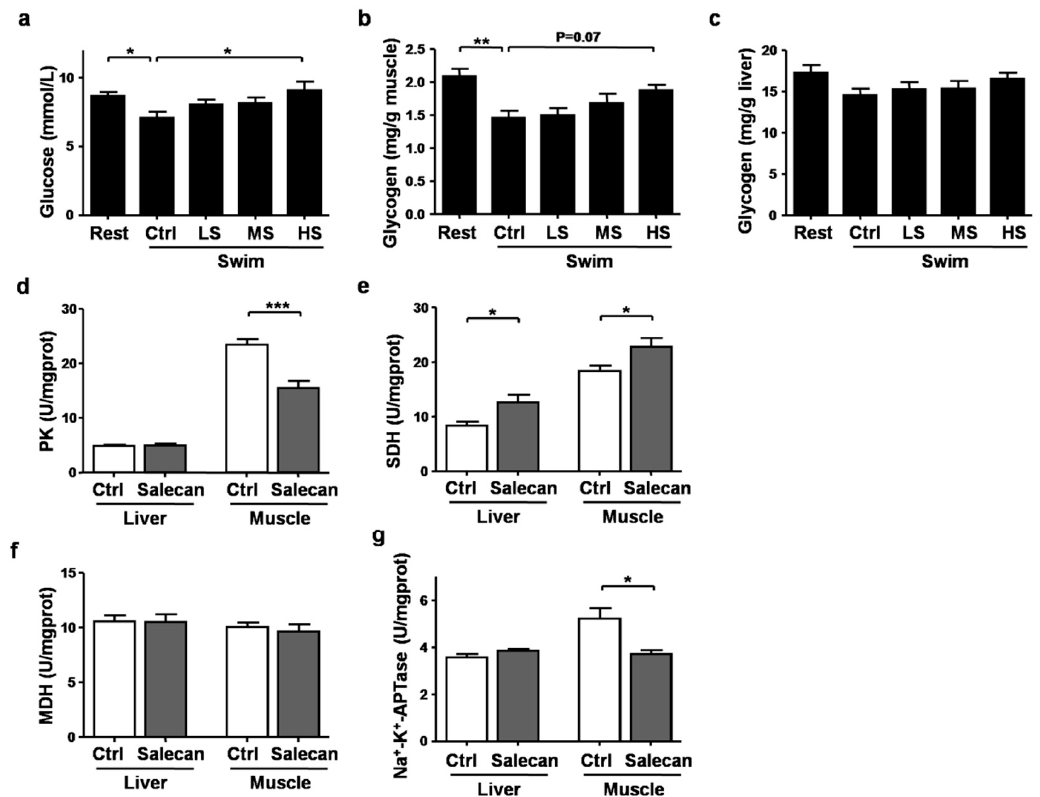
Figure 5. The regulatory effects of Salecan on glucose metabolism including ( a ) serum glucose, ( b ) muscle glycogen content, ( c ) liver glycogen contents and the effects of Salecan on energy metabolic enzymes including ( d ) pyruvate kinase (PK), ( e ) succinate dehydrogenase (SDH), ( f ) malate dehydrogenase (MDH), and ( g ) Na + -K + -ATPase. Data are expressed as mean ± SD, N = 6, * p < 0.05, ** p < 0.01, *** p < 0.001.